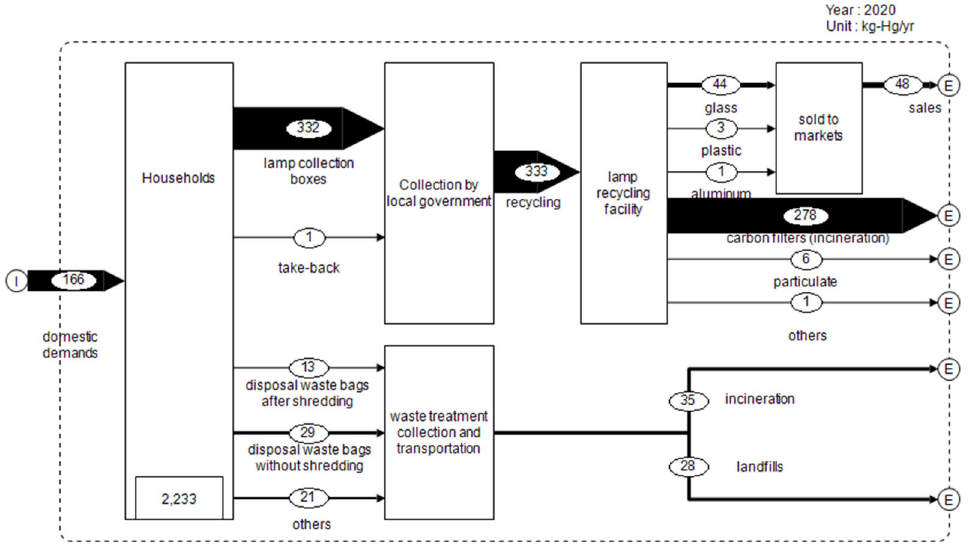
Figure 6. Mercury flow in fluorescent lamps from households in South Korea